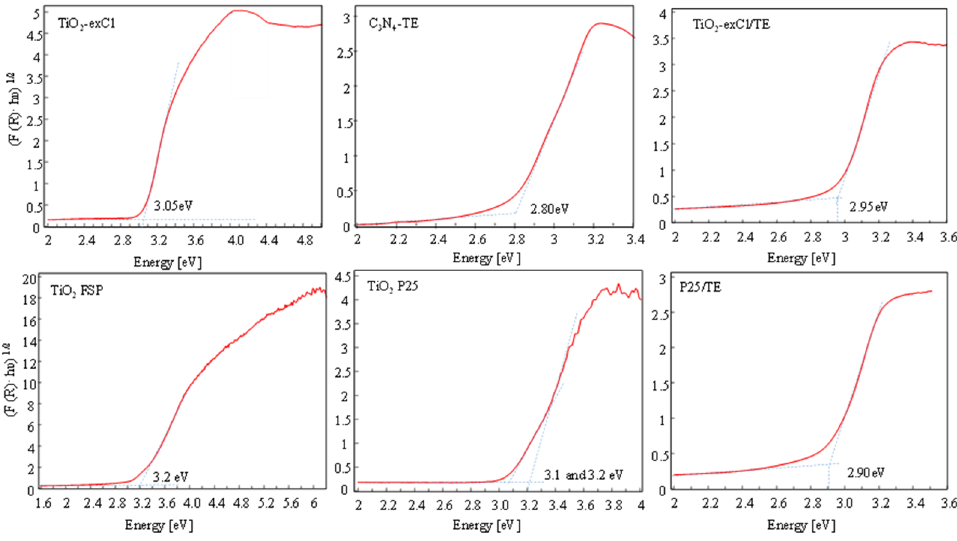
Figure 4. Tauc plots determined from the DR UV-Vis spectra of all the catalysts used.